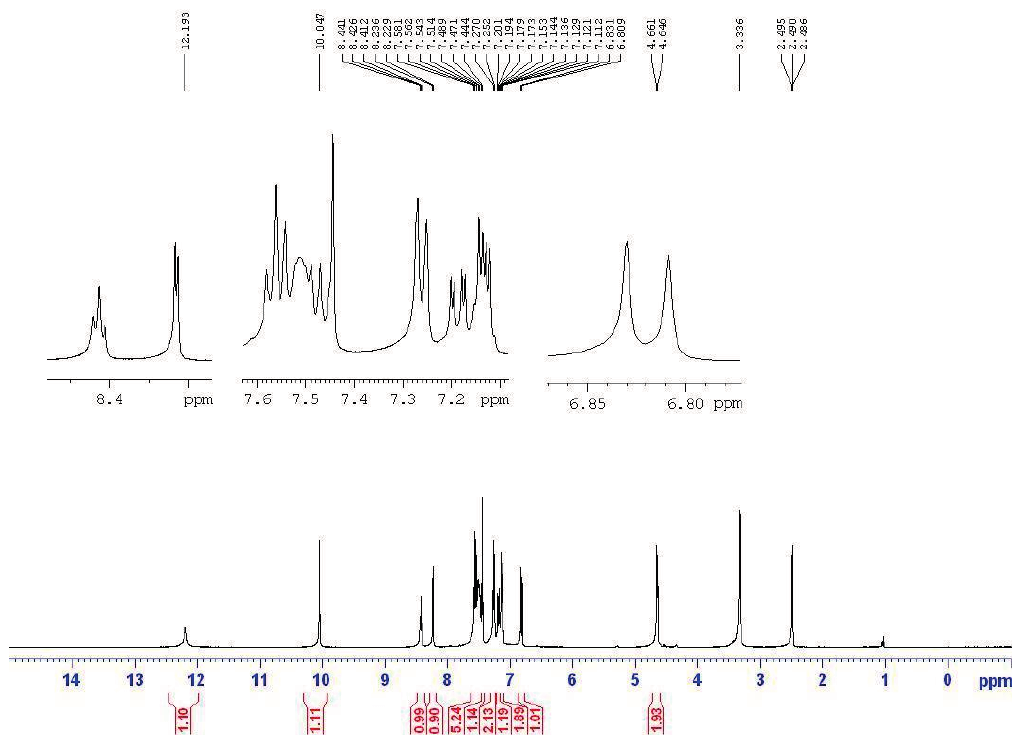
Figure 3. The NMR spectrum of semicarbazone 13a .